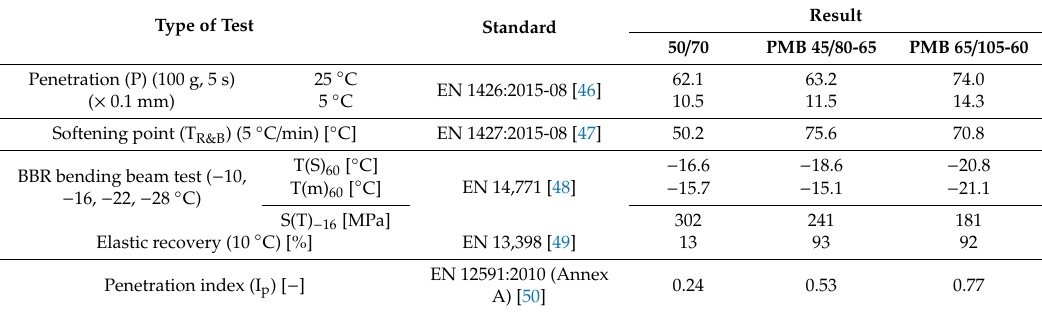
Table 1. Properties of 50 / 70 paving grade bitumen and two modified bitumens: PMB 45 / 80-65 and PMB 65 / 105-60.